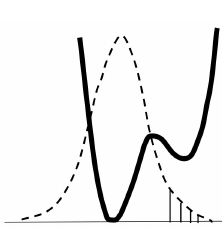
Figure 5. Calculation [17] of the distribution function of proton density (left) and potential energy of a proton (right) depending on the length of the O–H ··· O bond. ( a ) weak bond, d O ··· O = 2.85 Å, ( b ) strong bond, d O ··· O = 2.43 Å, ( c ) strong bond, d O ··· O = 2.29 Å, ( d ) extremely strong bond, d O ··· O = 2.17 Å. δ = R OaH − R ObH . (See also Figure 1 in [17]). The horizontal dotted line indicates the thermal energy level kT at 25 K. The figure is reproduced with permission from Ref. [17], copyright (2005) European Chemical Societies Publishing.